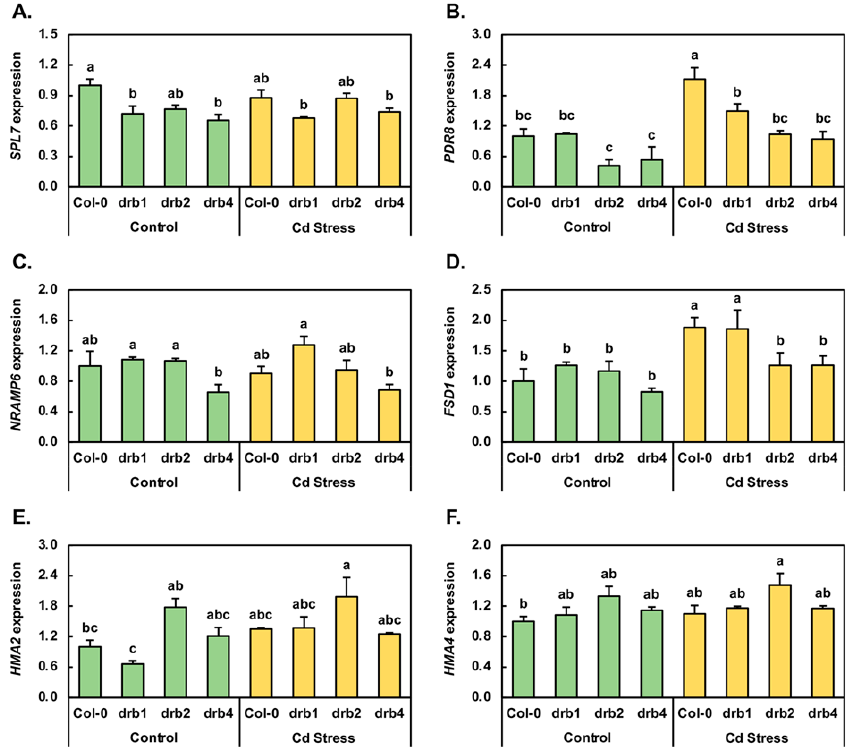
Figure 2. RT-qPCR quantification of the expression of Arabidopsis genes known to be responsive to cadmium stress. A standard RT-qPCR approach was used to quantify the transcript abundance of a select group of Arabidopsis genes known to be responsive to Cd stress, including ( A ) Squamosa promoter binding protein-like 7 ( SPL7) ; ( B ) PDR8 ; ( C ) natural resistance-associated macrophage protein ( NRAMP6) ; ( D ) FE superoxide dismutase 1 ( FSD1) ; ( E ) heavy metal ATPase 2 ( HMA2) and ( F ) heavy metal ATPase 4 ( HMA4 ). The expression of these six genes was analyzed in 15-day-old Col-0, drb1 , drb2 and drb4 plants following their exposure to a 7-day 50 μ M CdCl 2 stress treatment regime for comparison to the control grown counterpart of each Arabidopsis line. ( A – F ) Statistical data were analyzed using one-way ANOVA and Tukey’s post-hoc tests. The statistically significant differences are indicated by a different letter ( p- value < 0.05) above each column of each histogram.